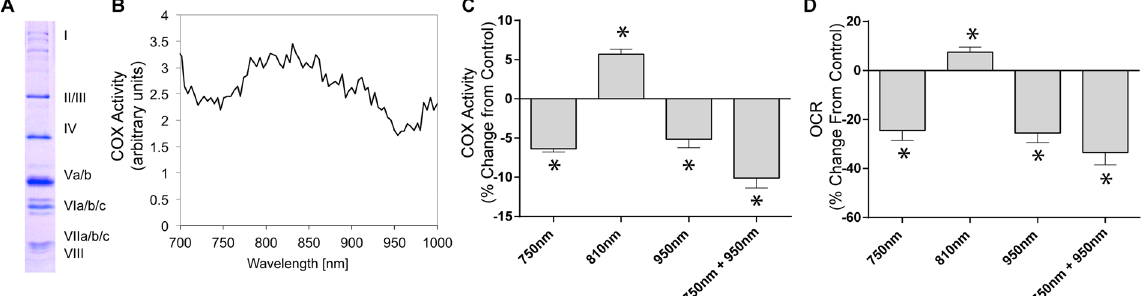
Figure 1. NIR modulates COX activity and mitochondrial oxygen consumption rate. ( A ) Isolated regulatory- competent bovine COX separated into its subunits on a high-resolution urea/SDS-PAGE Coomassie-stained gel. Subunits are indicated in roman numerals. ( B ) Representative scan of wavelength-dependent COX activity identifying the 750 nm and 950 nm wavelength rages as inhibitory regions. ( C ) Effect of NIR emitted by LED diodes confirms that 750 nm and 950 nm NIR inhibit COX in vitro while 810 nm NIR activates the enzyme. Data were obtained over a 3-min interval of irradiation and normalized to non-irradiated samples (n ≥ 4; * p < 0.05). ( D ) NIR irradiation modulates oxygen consumption rate (OCR) in a wavelength specific manner. 750 nm and 950 nm NIR reduce OCR below the basal respiration rate and 810 nm NIR increase mitochondrial OCR (n ≥ 4; * p <